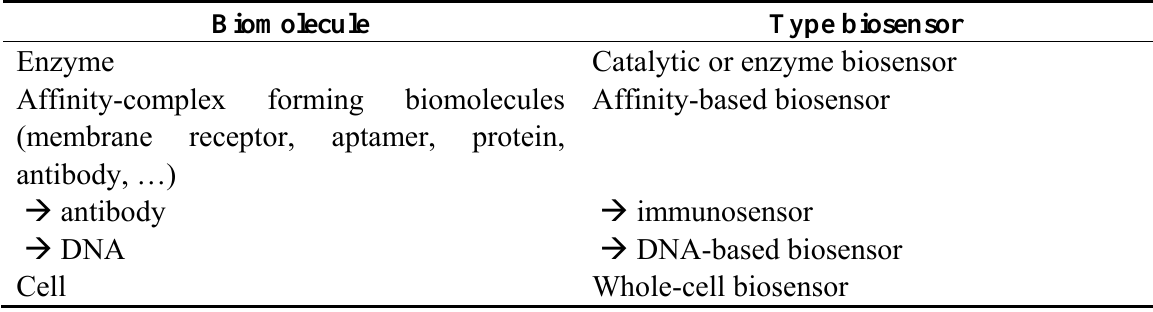
Table 2. Biosensor classification based on the type of biological receptor molecule.